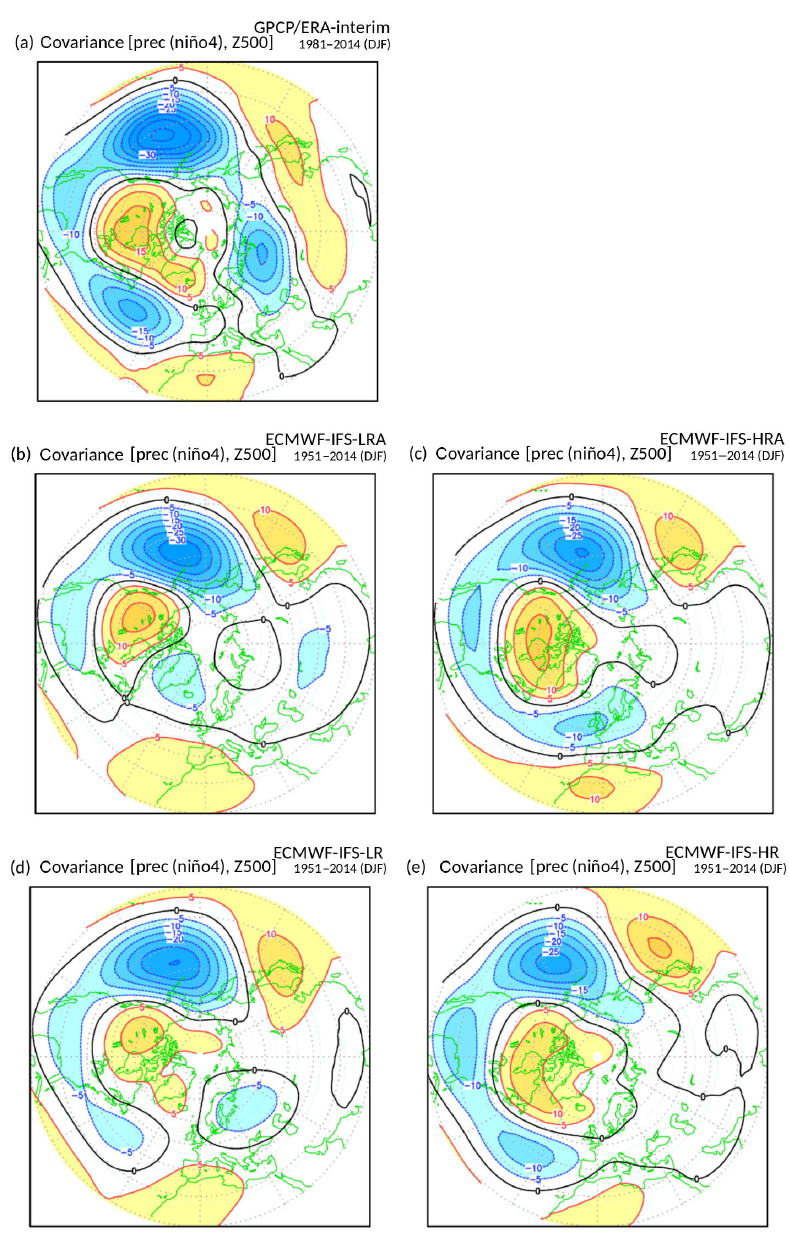
Figure 20. As Fig. 19 but for DJF 500hPa geopotential height